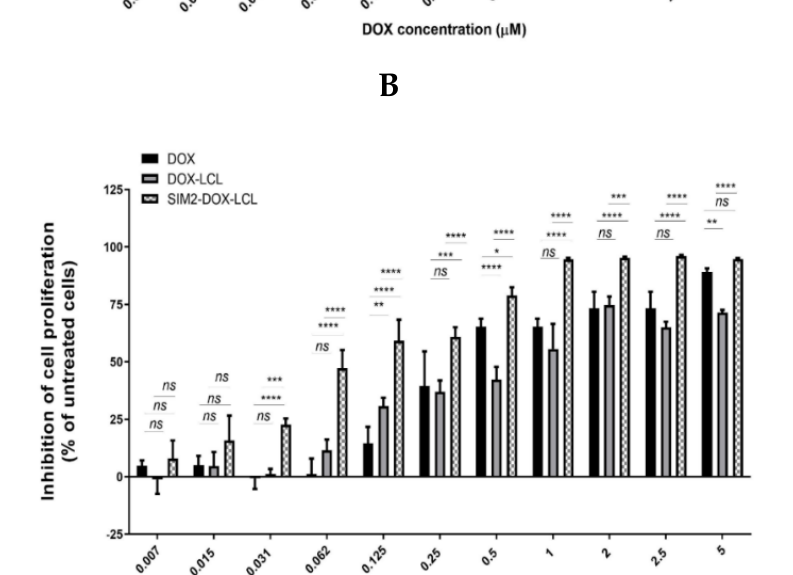
Figure 12. The effects of liposomal co-administration of SIM and DOX on the proliferation of C26 murine colon carcinoma cells co-cultured with murine macrophages. The results show cell prolifera- tion at 48 h after incubation of macrophages and C26 co-cultured cells with free DOX or liposomal DOX. For DOX, three liposomal formulations were tested and statistically compared in terms of the effects on the inhibition of co-cultured cell proliferation: long circulating liposomes encapsulated with DOX (DOX-LCL) (A,B), long circulating liposomes co-encapsulated with SIM (0.93 µ M) and DOX (0.23 µ M) (SIM1-DOX-LCL ( A ), and long circulating liposomes co-encapsulated with SIM (3 µ M) and DOX (0.25 µ M) (SIM2-DOX-LCL) ( B ). Data are presented as the mean ± standard deviation of triplicate measurements. The results are expressed as percentage of inhibition of co-cultured cells proliferation following free or liposomal DOX treatments, compared to the proliferation of control cells (untreated cells). Significance was considered at values of p < 0.05 (ns, p > 0.05; * p < 0.05; ** p < 0.01; *** p < 0.001; **** p <